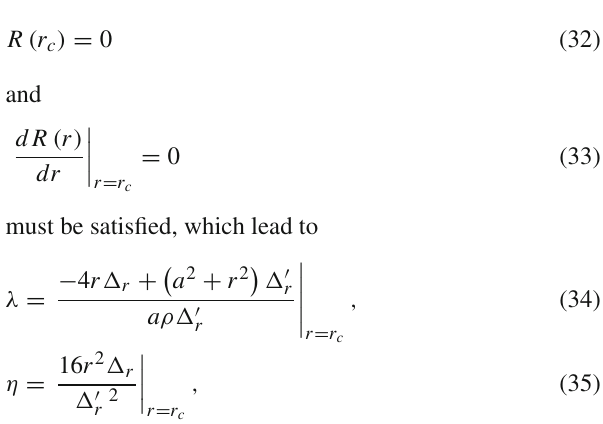
Fig. 8 The shape of shadows and corresponding distortion parame- ters (cid:15) as function of (cid:13) γ for selected different parameters for observers located at r = 4. Here we set M = 1. a Shadows and distortion parame- ters of rotating Hayward–de Sitter black holes of selected different cos- For spherical